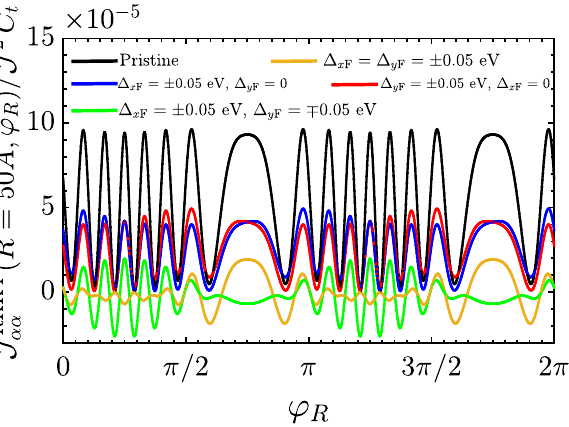
Figure 5. The behavior of the RKKY interaction J RKKY αα ( R , ϕ R )/ J 2 C t as a function of ϕ R at fixed R for different ferroelectric distortion strengths. The obvious periodic feature of the RKKY coupling in the pristine and distorted square lattice of the SnTe (001) surface is given by J RKKY αα ( R , ϕ R )